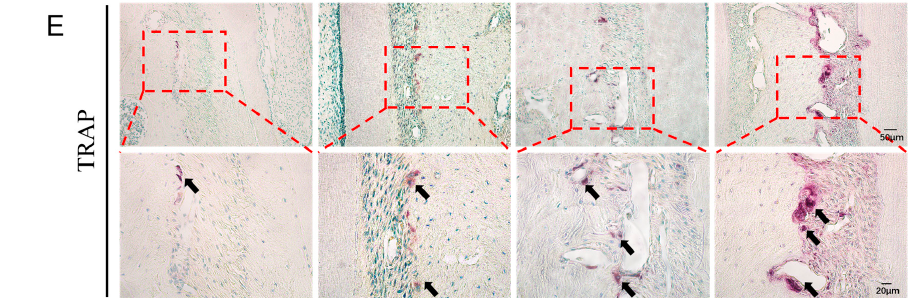
Figure 2. ( A ) Micro-CT (Scale bar = 1 mm). ( B ) BMD, BV/TV, Tb.Th, and the distance from CEJ to ABC were analyzed. ( C ) The results of the periodontal clinical index of rats in each group include pocket depth (PD), tooth mobility (TM), and bleeding index (BI). ( D ) H&E staining results of maxillary first molars (Scale bar = 200 µ m). M1 indicates the maxillary first molar. The black triangle means the alveolar bone ridge and H&E staining results in gingival tissue of rat maxillary first molars at 200 × and 400 × magnification. The black arrows show inflammatory cells. The red arrows show the epithelial pegs. ( E ) Results of TRAP staining of maxillary first molars in rats at 200 × and 400 × magnification. The black arrows indicate osteoclasts. CRD: circadian rhythm disorders. C: control; CRD-C: CRD without periodontitis. P: periodontitis group. CRD-P: CRD with periodontitis. Data are presented as the mean ± SD. ns, not significant difference; * p < 0.05; ** p < 0.01; *** p < 0.001; **** p <